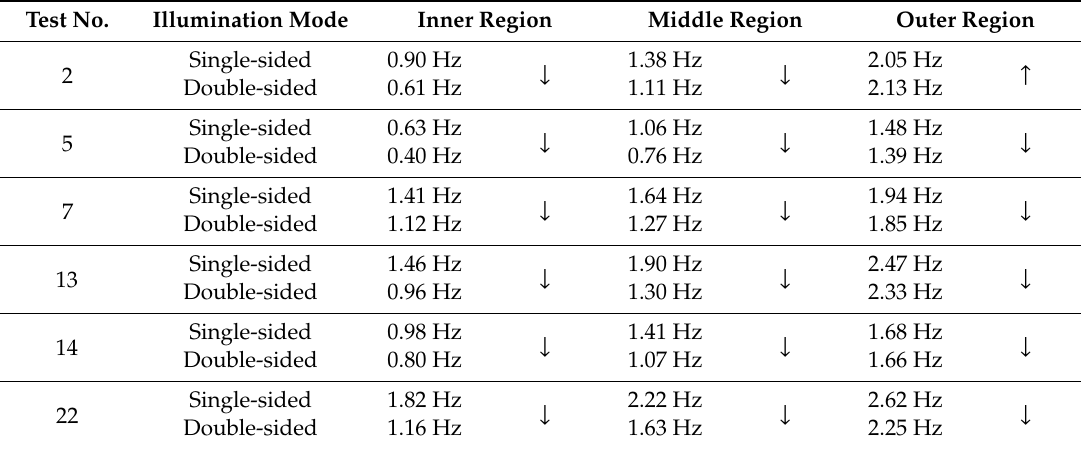
Table 6. Average L / D cycle frequencies of particles in three regions under single-sided and double-sided illuminations for tests 2, 5, 7, 13, 14, and 22 (arrows represent the relative changes in frequency; ↑ is increased, ↓ is decreased).